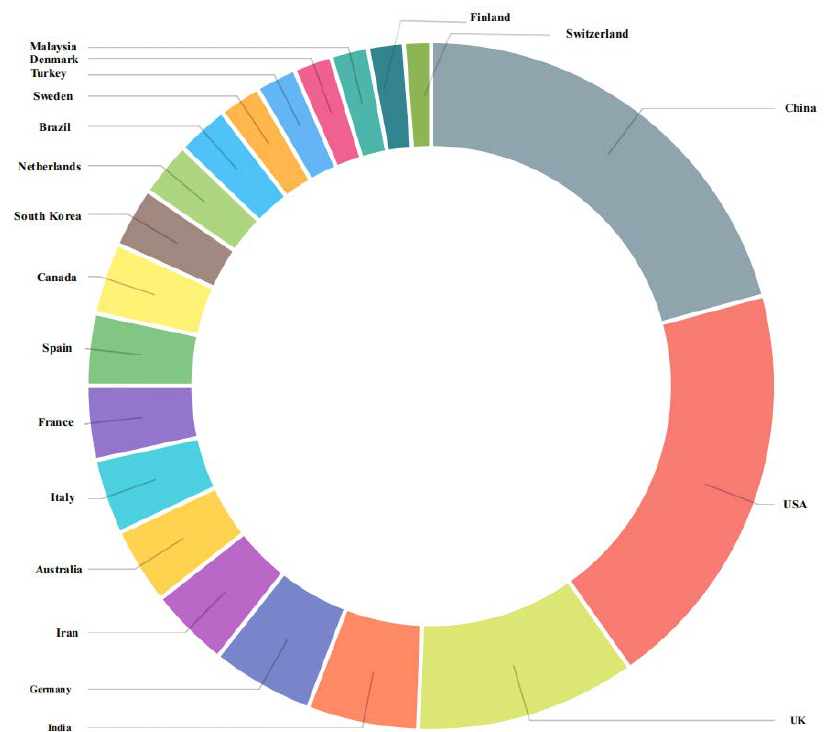
Figure 4. Pie chart of the top 20 countries/regions for publications in SCM.